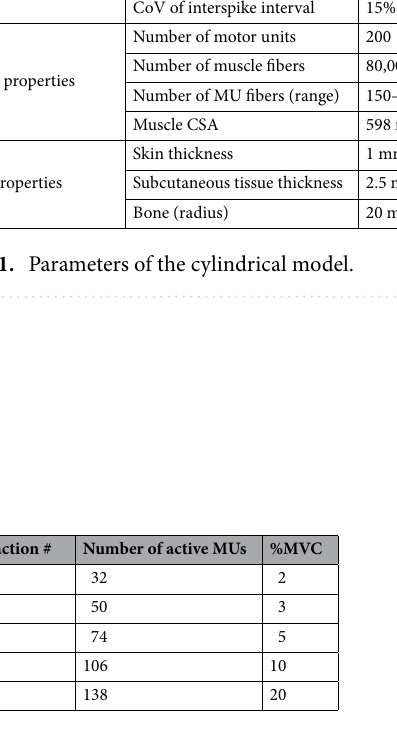
Table 2. Simulated contraction